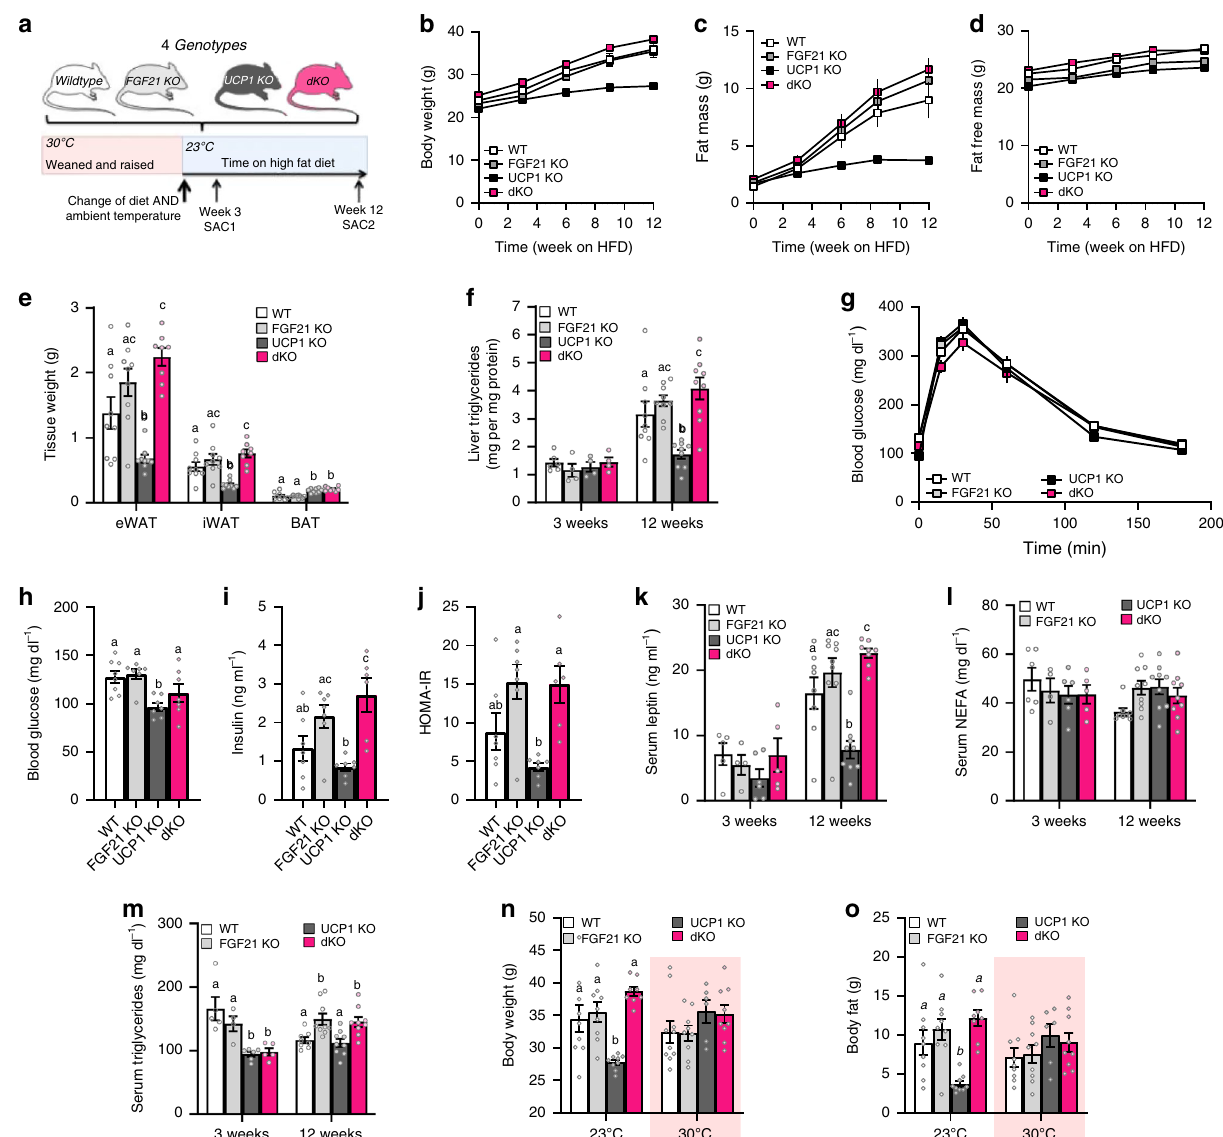
Fig. 2 FGF21 entirely controls the resistance to diet-induced obesity in UCP1 KO mice. a Scheme depicting the study design (SAC: sacri fi ce). At the age of 10 – 12 wks, WT, FGF21 KO, UCP1 KO and UCP1/FGF21 dKO mice were transferred from 30 to 23 °C and fed a high fat diet (HFD) for 3 or 12 wks. Trajectories of b body weight, c body fat and d fat free mass. e Weights of epididymal and inguinal WAT; and BAT. f Liver triglycerides after 3 and 12 wks of HFD. g Glucose tolerance test after 8 wks of HFD (4 h food withdrawal); h basal blood glucose, i insulin levels and j HOMA-IR. k Serum leptin, l NEFA and ( m ) triglyceride (TG) levels after 3 and 12 wks of HFD. n Mean body weight and o body fat of mice fed HFD for 12 weeks at 23 or 30 °C. b – e : n = 9/9/9/9 WT/FGF21 KO/UCP1 KO/dKO; g : n = 8/8/9/9; n : n = 8/7/7/7; I , j : n = 7/7/7/6; f : n = 6/4/4/4 – 9/9/9/9 3 wks WT/FGF21 KO/UCP1 KO/dKO –